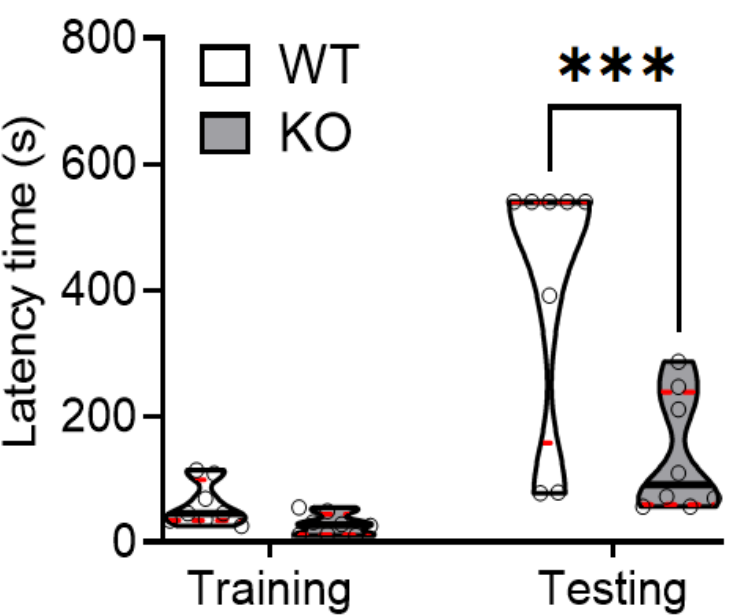
Figure 1. SREBP-1c deficiency significantly impairs learning and memory function in mice. Using the passive avoidance test, WT and SREBP-1c KO mice were trained using mild electrical foot shocks. Both groups were tested 24 h after training. Cross-over latency (s) was assessed to evaluate memory retention. SREBP-1c KO mice showed a significantly lesser increase in the cross-over latency before entering the dark room during testing than WT mice (WT: 406 ± 208.77 s, KO: 138.3 ± 94.40 s, n = 8 per group; F interaction (1,14) = 10.17, p = 0.0002). The upper and lower dashed red lines signify the upper and lower quartiles, respectively, and the median is represented by a solid black line within a violin plot. *** p < 0.001 vs. WT. WT, wild-type littermate; KO, SREBP-1c KO group.